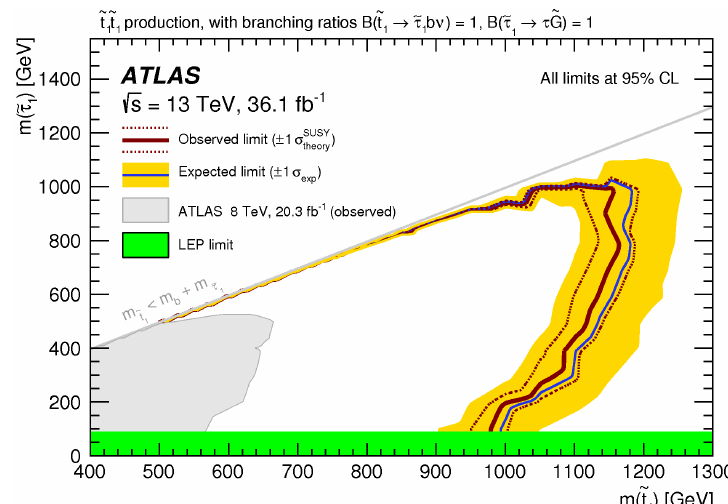
Figure 5: Exclusion contours at 95% CL in the plane of top-squark and tau-slepton mass for the simplified model [ 11 ] .